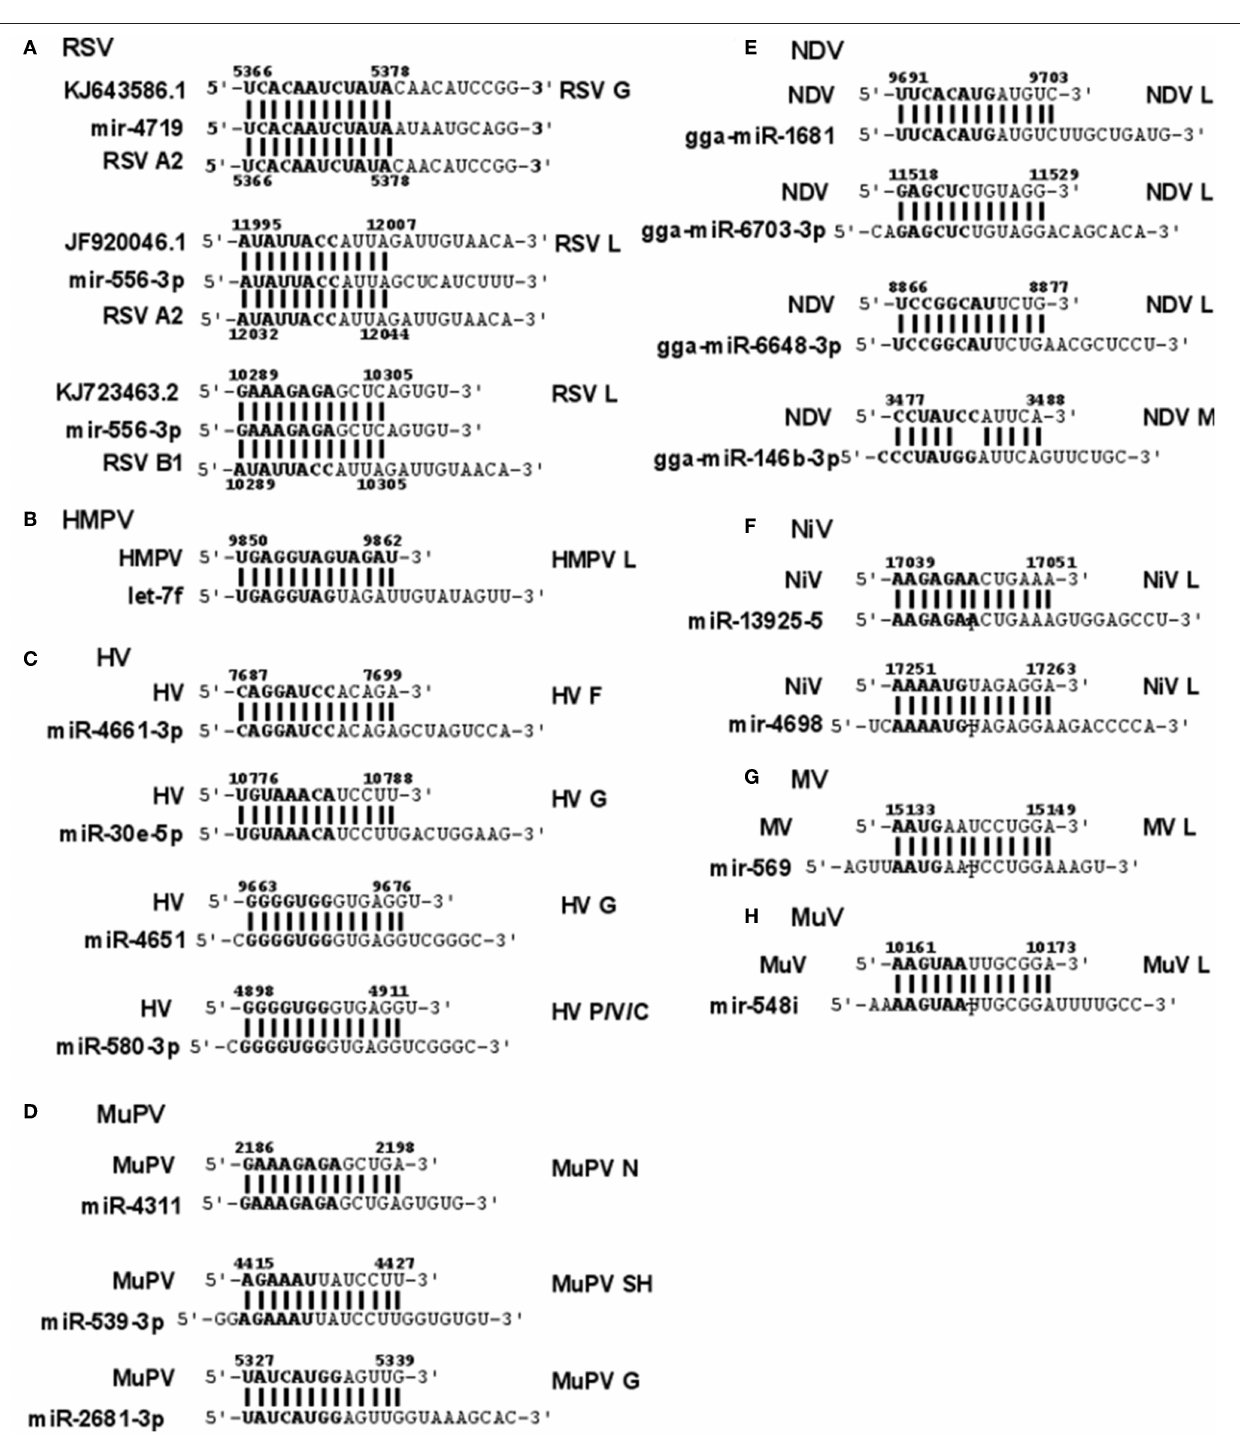
FIGURE 2 | Sequence alignments of miRNA vSMs encoded by different paramyxoviruses. Alignments show identity between host miRNA seed sites and the corresponding vSM across Paramyxoviruses . Nucleotide numbers indicated viral genome coordinates while labels on the right indicate encoding viral gene. miRNA seed sequence is indicated in bold. Straight lines indicate perfect